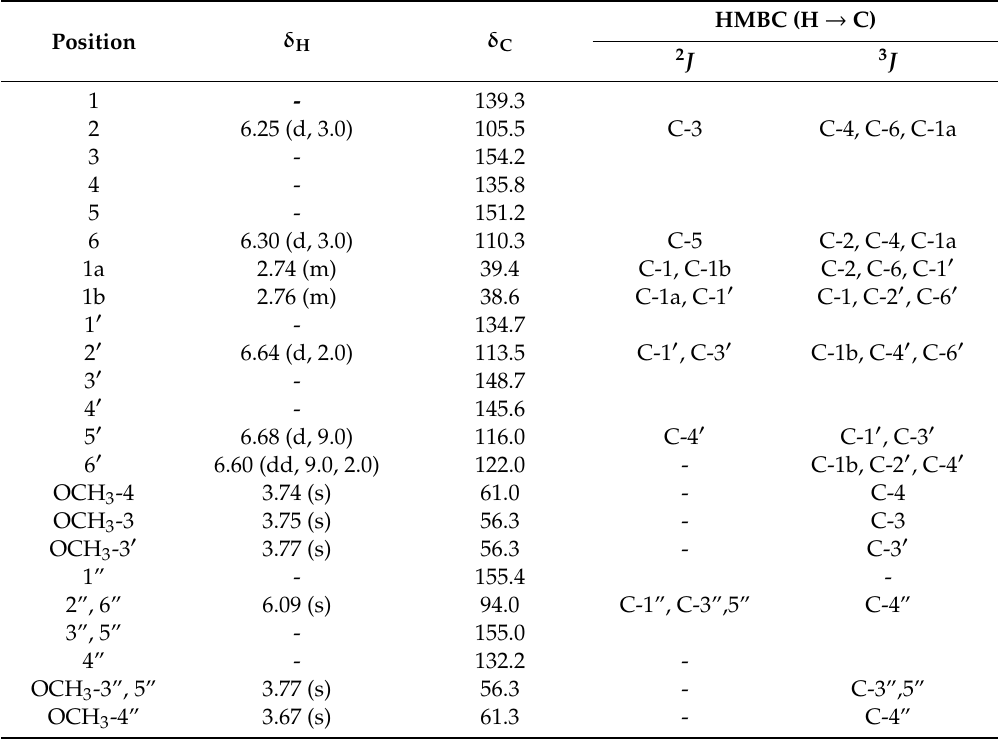
Table 1. 1 H (300 MHz) and 13 C (75 MHz) nuclear magnetic resonance (NMR) data for compound 1 (CD 3